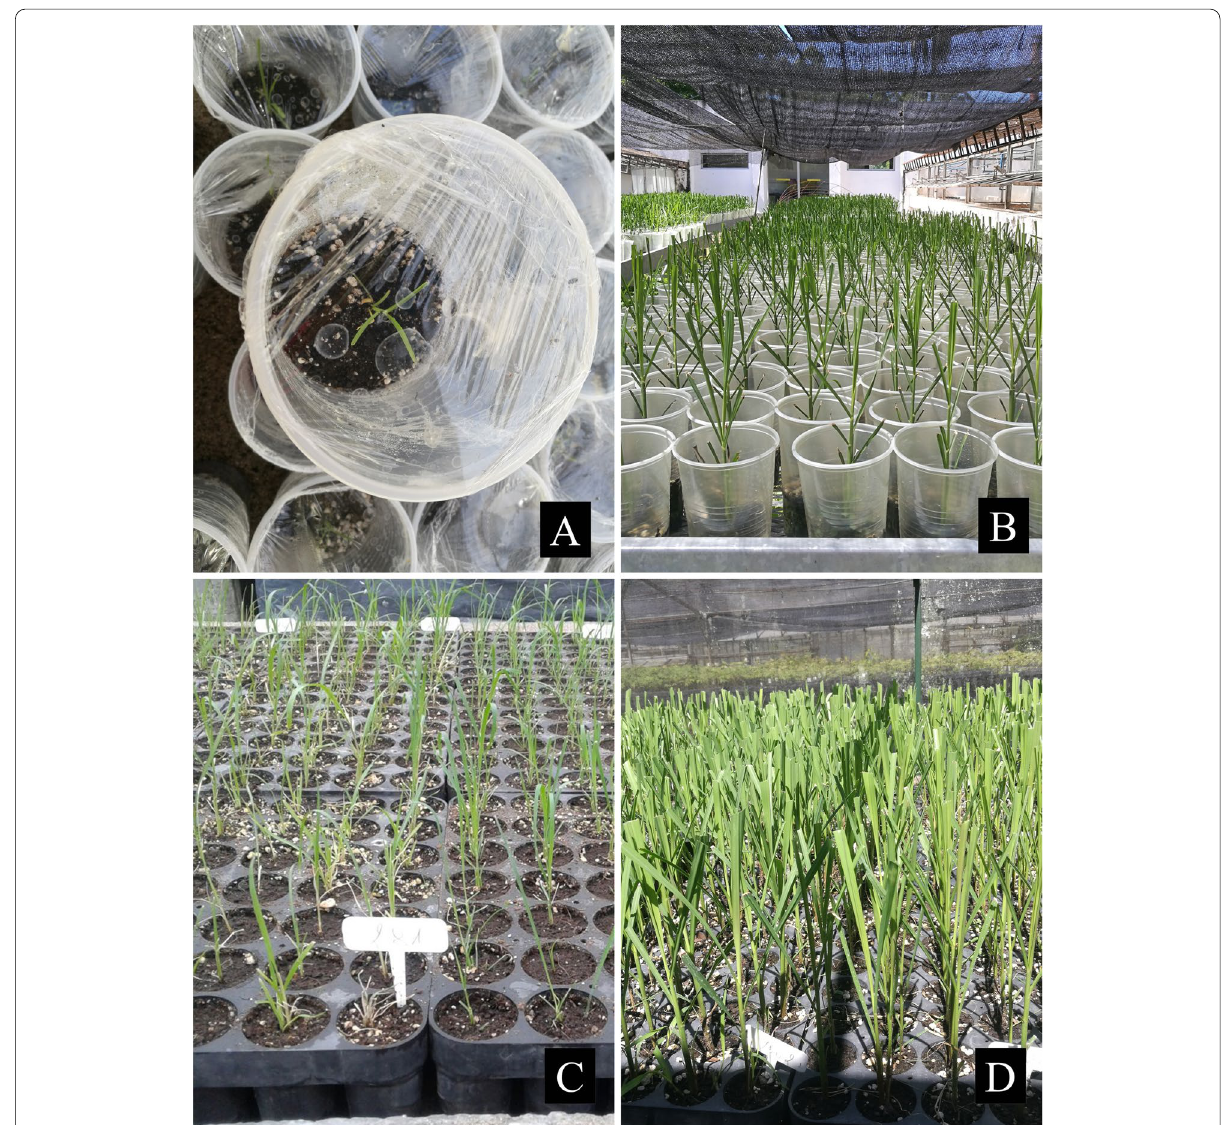
Fig. 1 Procedures for the acclimatization. A , B Plants acclimatized in transparent pots covering with a thin plastic for 1 week. C , D Plants acclimatized in plastic seedling trays without